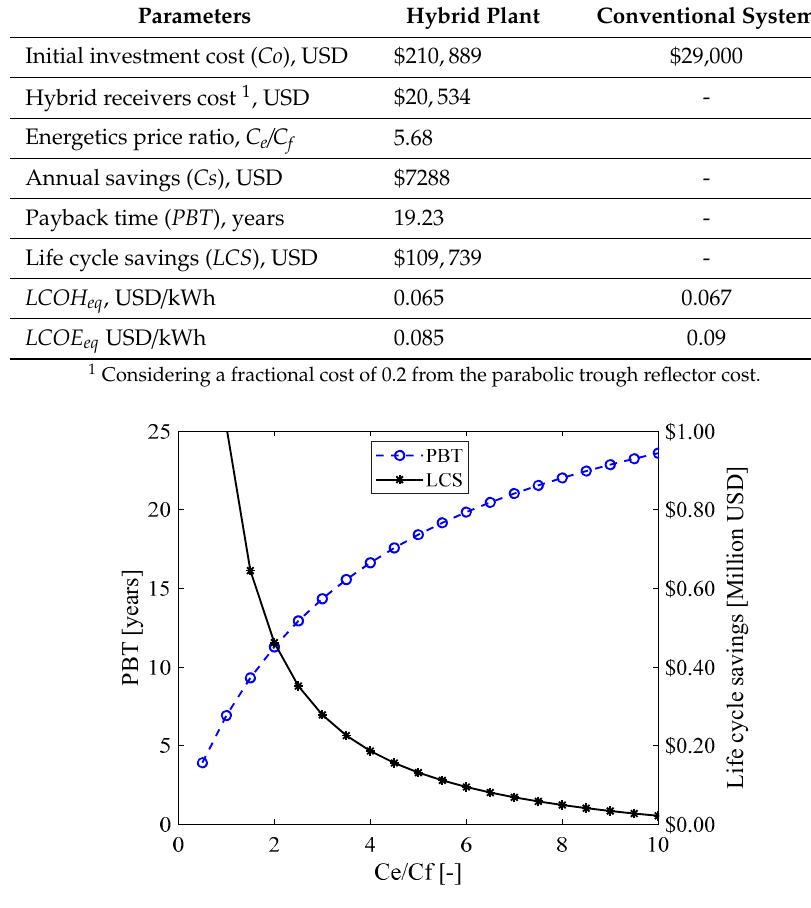
Figure 7. Payback time and life cycle savings versus the energetics price ratio ( C e /C f ) (Source: Author own calculation).